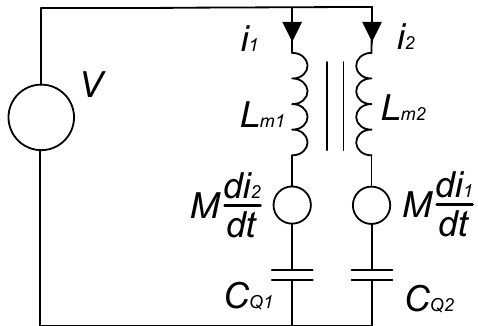
Figure 5. Approximated equivalent circuit of Figure 4.